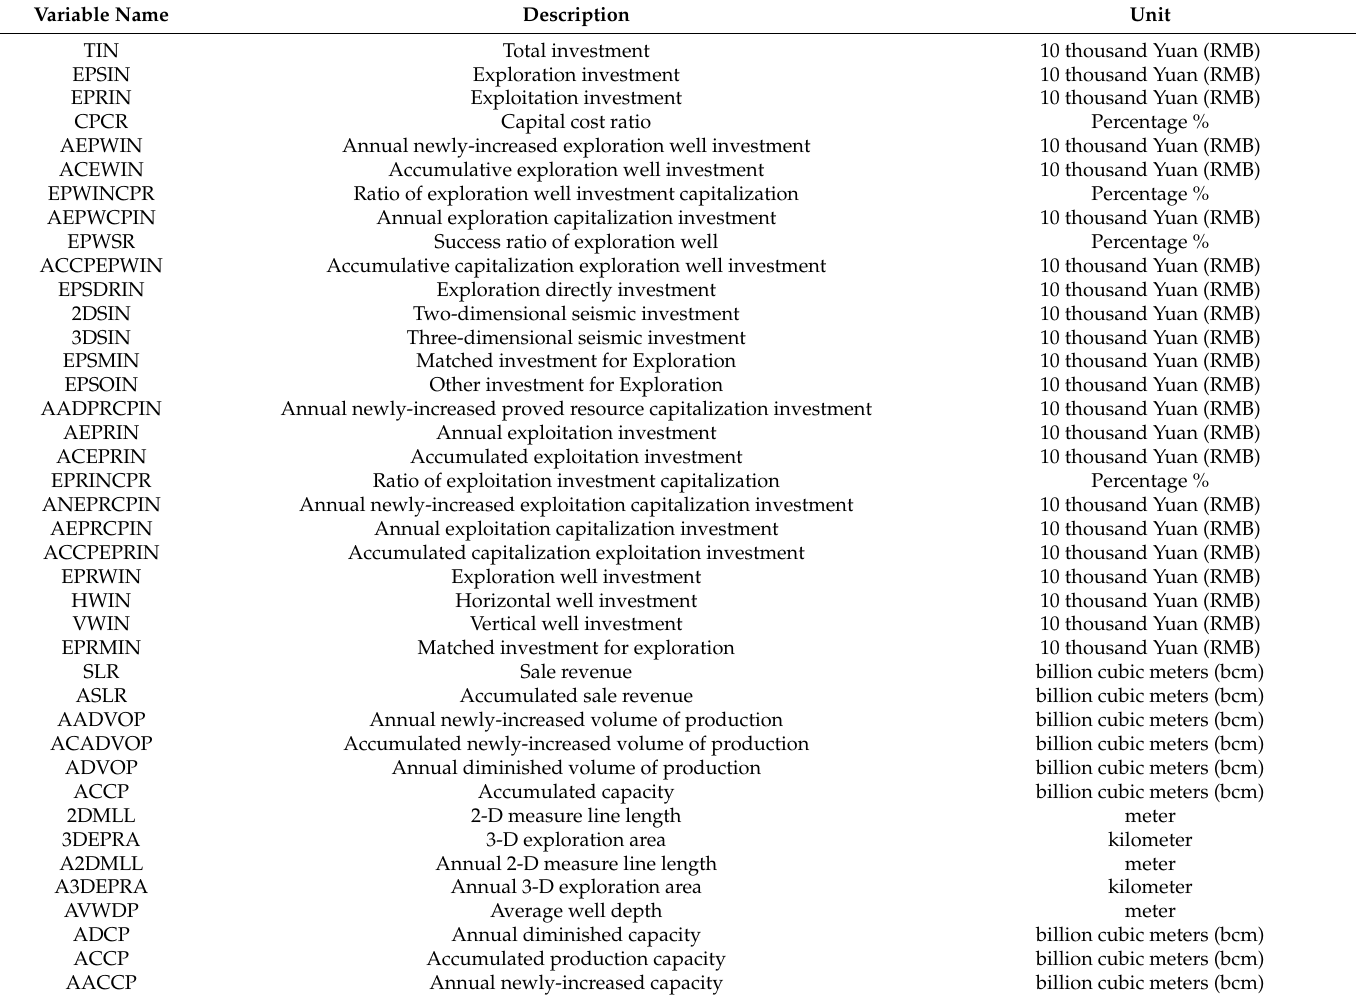
Table 1. Parameter list of the SD